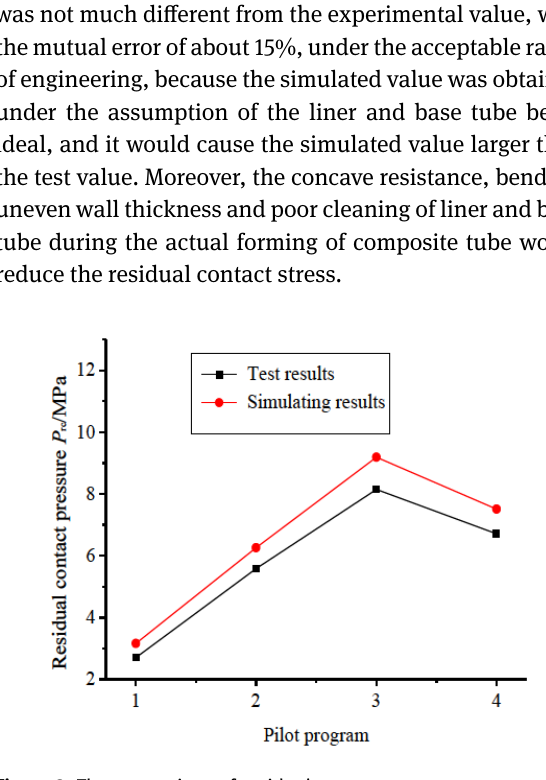
tube carbon steel tube cut off 10mm, and the complete lined stainless-steel tube was left. The two Φ 20 mm holes were drilled at both ends of specimens to conveniently clamp for pull-out test. The resulting entity diagram was shown in Figure 7.